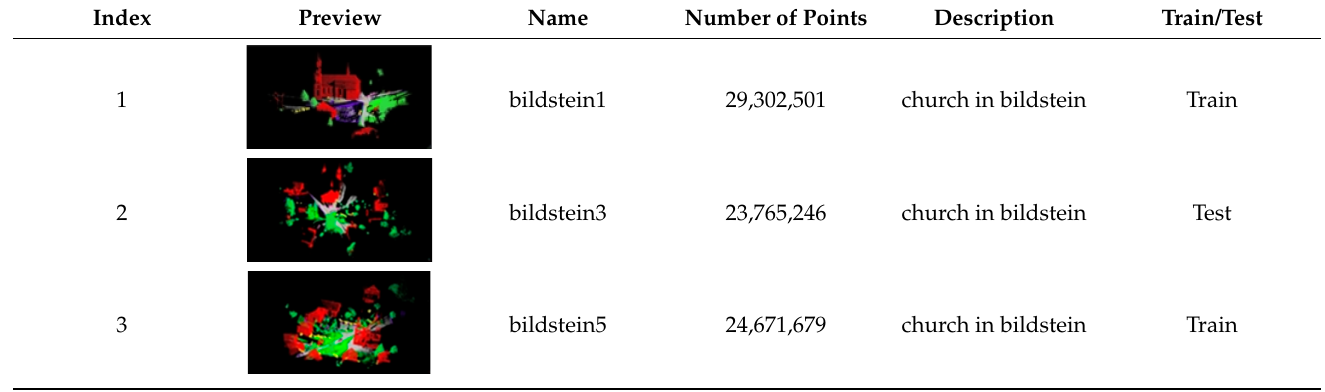
Table 1. Summary of basic information of 15 labelled point